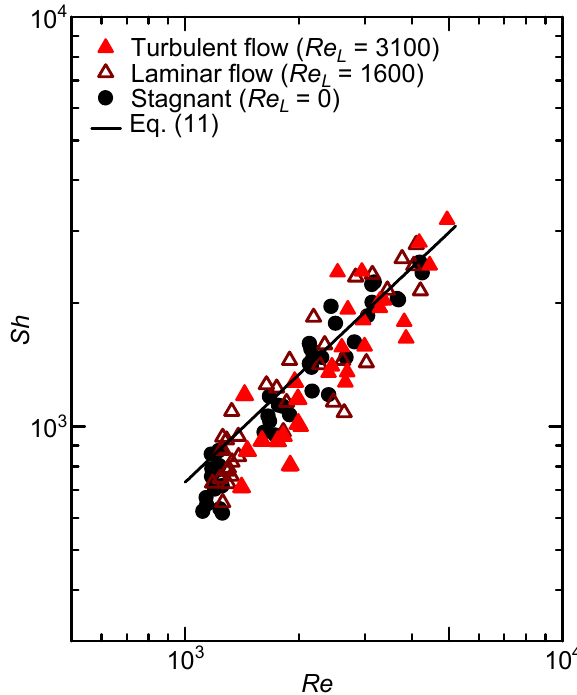
Fig. 6 Sherwood number of a bubble in pipe